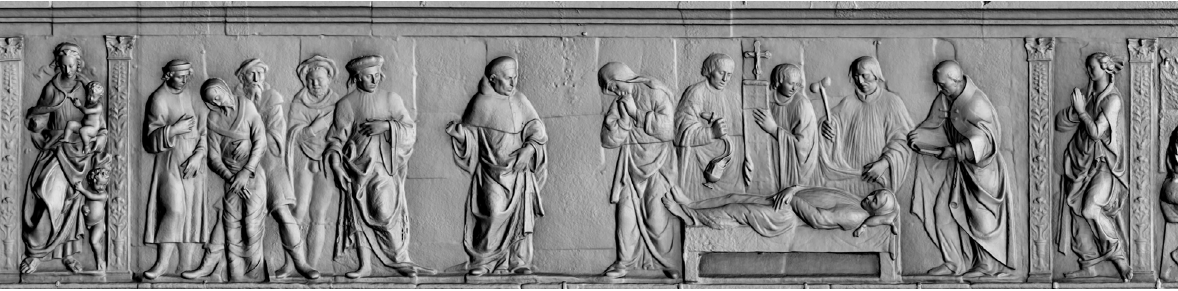
Figure 6. Mesh model of one of the sub-projects (05 in Table 1)